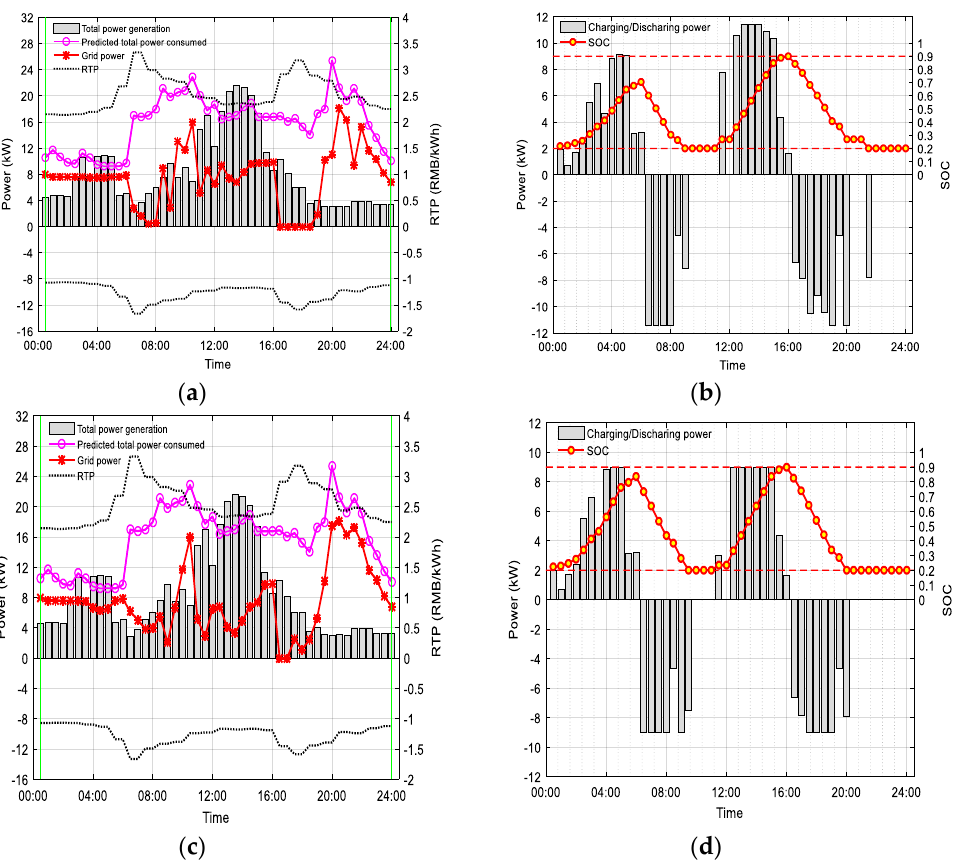
Figure 10. Power dispatching results of rural microgrid: ( a ) load and generation power scheduling result in case 1; ( b ) energy-storage scheduling result in case 1; ( c ) load and generation power scheduling result in case 2; ( d ) energy-storage scheduling results in case 2.